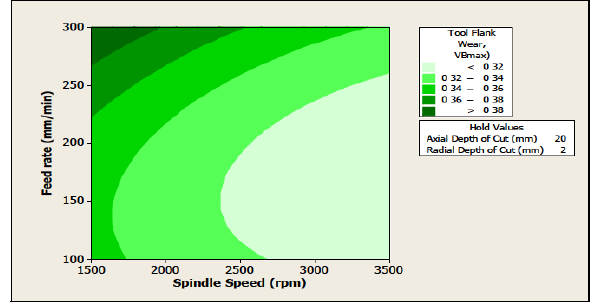
Figure 3: Contour plot of tool wear vs. feed rate and spindle speed.